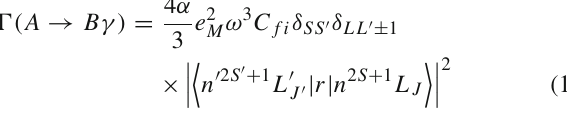
TheresultsofRef.[40]areestimatedwiththemixingangle θ 1 P = − 38